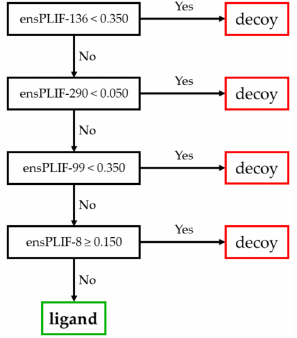
Figure 3. The best decision tree to identify ligand for CXCR4.